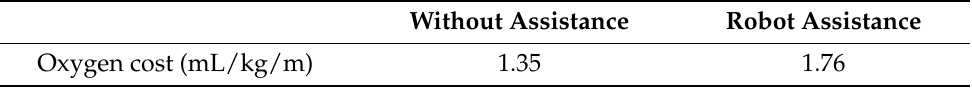
Figure 13. Kinematic result of a walking trial wearing a torque-controlled robotic device and using a wheeled walker. The first vertical dashed lines represent the single limb support phase (opposite foot off), the second vertical dashed lines represent the second double limb support phase (opposite foot contact), and the solid vertical lines represent initial swing. Table 3. Oxygen costs of the 6-min metabolic test of walking without and with Angel Legs using a wheeled